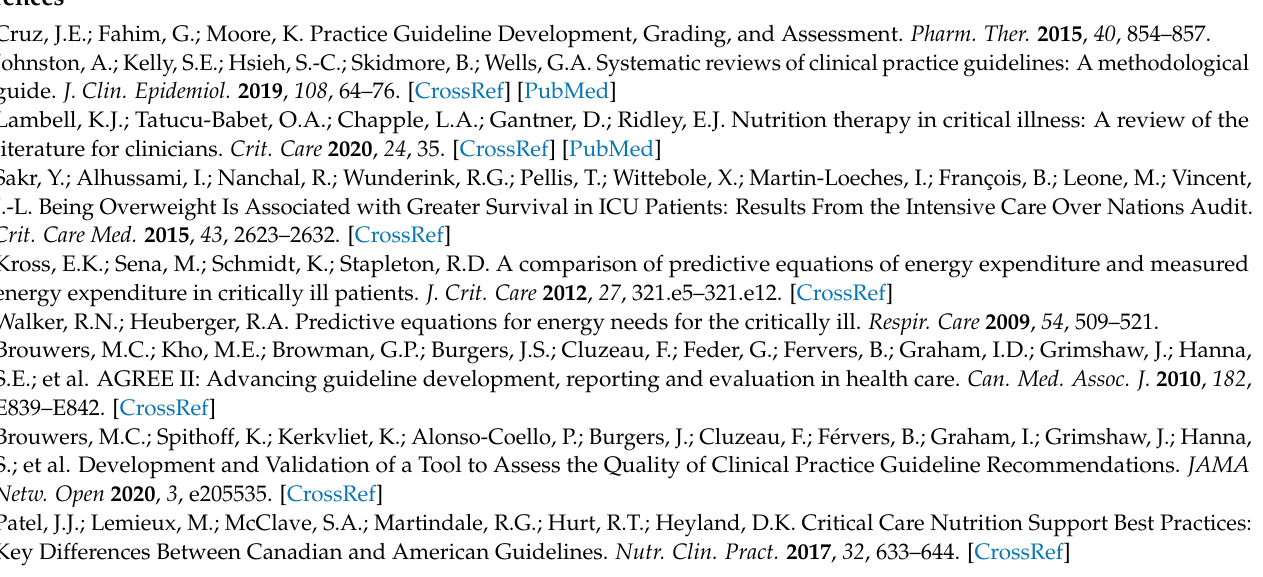
Figure S6: AGREE-REX raw items item scores in critically ill patients with obesity, Table S1: Medline Ovid Search, Table S2: Clinical practice guideline recommendations, Table S3: Median AGREE II item scores for included guidelines from all assessors, Table S4: Scaled domain scores (%) using the AGREE-REX tool for energy expenditure determination in general ICU populations and patients with obesity, Table S5: Median AGREE-REX item scores for energy expenditure in general ICU populations, Table S6: Median AGREE-REX item scores for energy expenditure in critically ill patients with